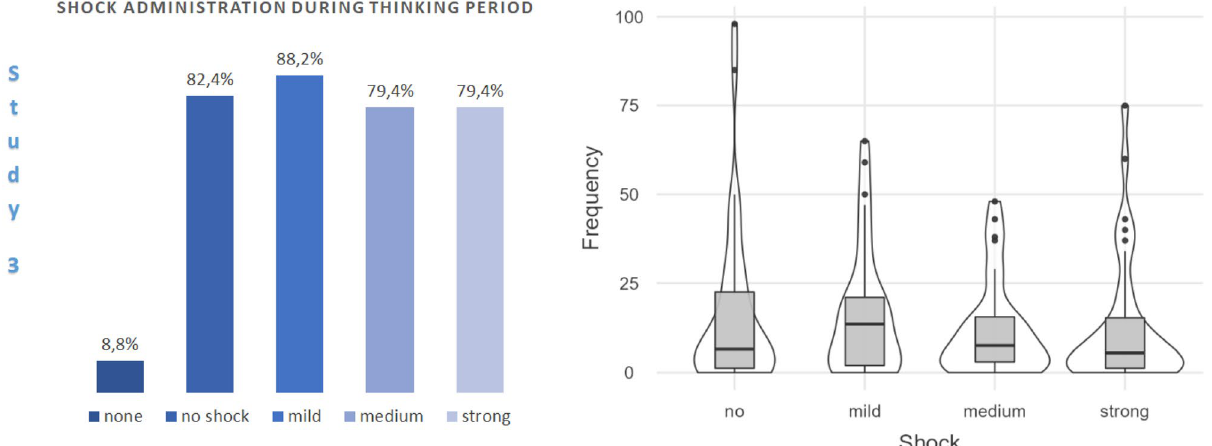
Figure 3. Proportion of participants ( n = 34) who administered shocks to themselves during the thinking period (left panel) and a violin plot with box plots of the frequencies of self-administered shocks as a function of shock type (right panel). Note that the ‘none’ bar in the left panel is mutually exclusive with the others; however, a participant can be counted in all other bars